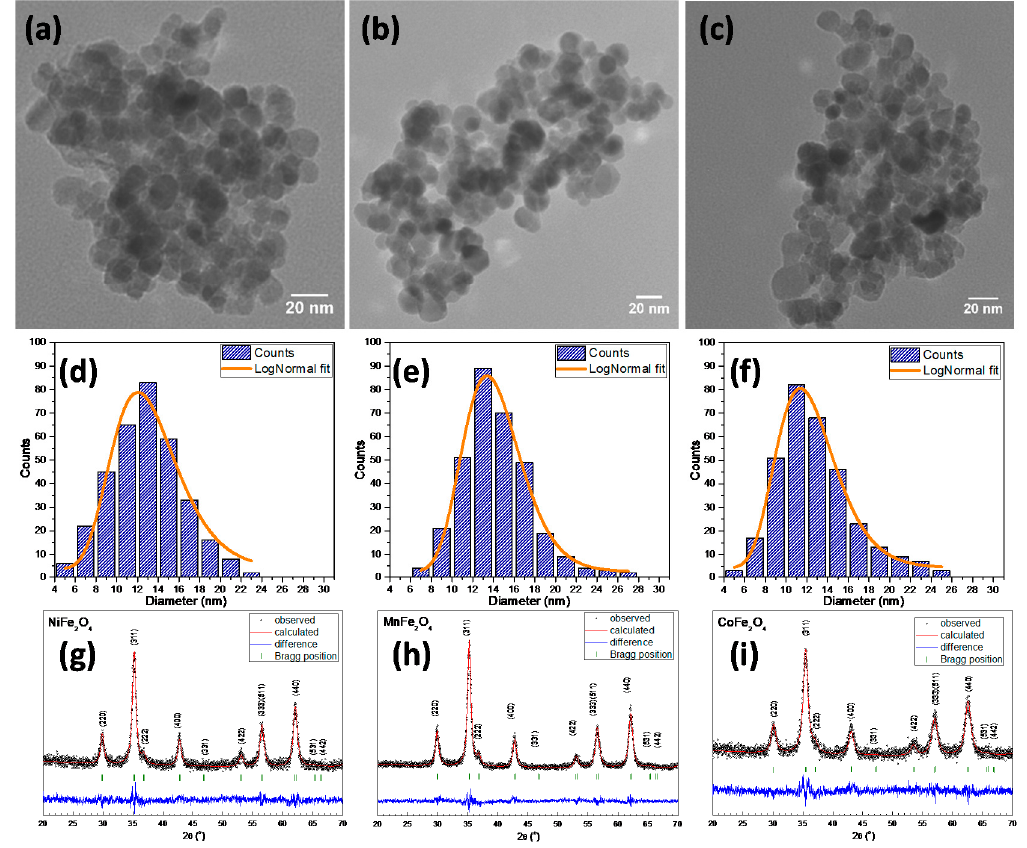
Figure 1. Large-scale TEM images, the size distribution histograms fitted to a log-normal distribution (orange lines), and the XRD diffractograms of ( a , d , g ) nickel, ( b , e , h ) manganese and ( c , f , i ) cobalt ferrite MNPs.